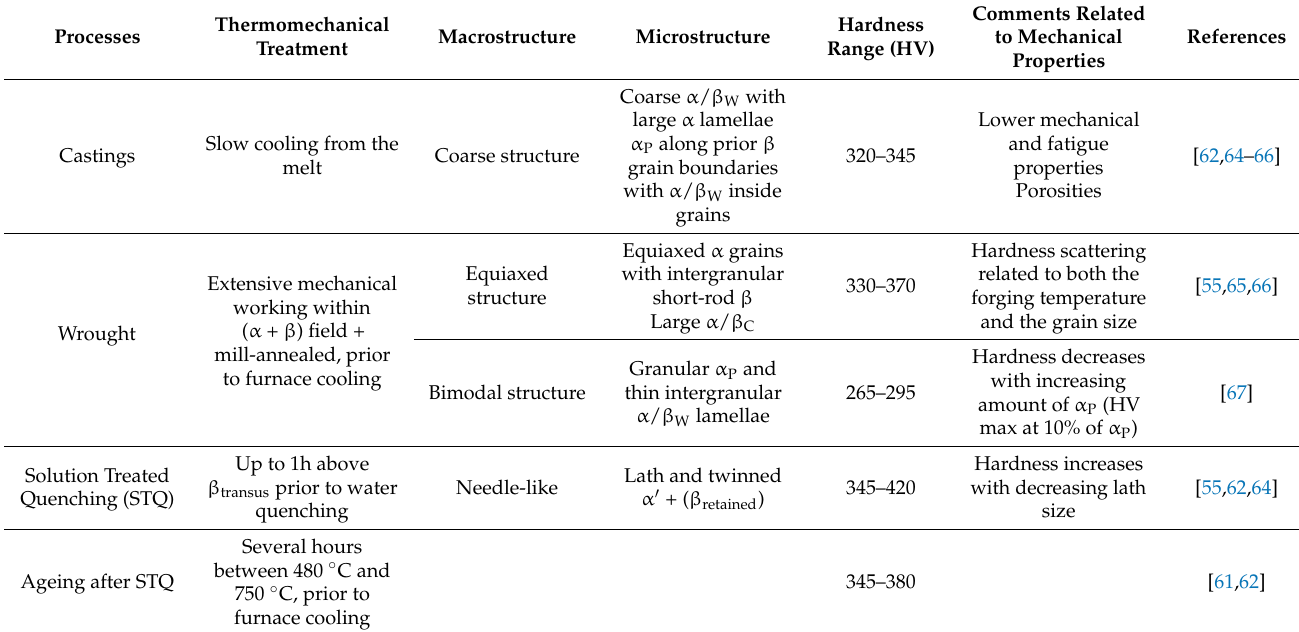
Table 1. Literature summarizing correlations between structure hardness of Ti6Al4V, for classical manufacturing processes. Thermomechanical Processes